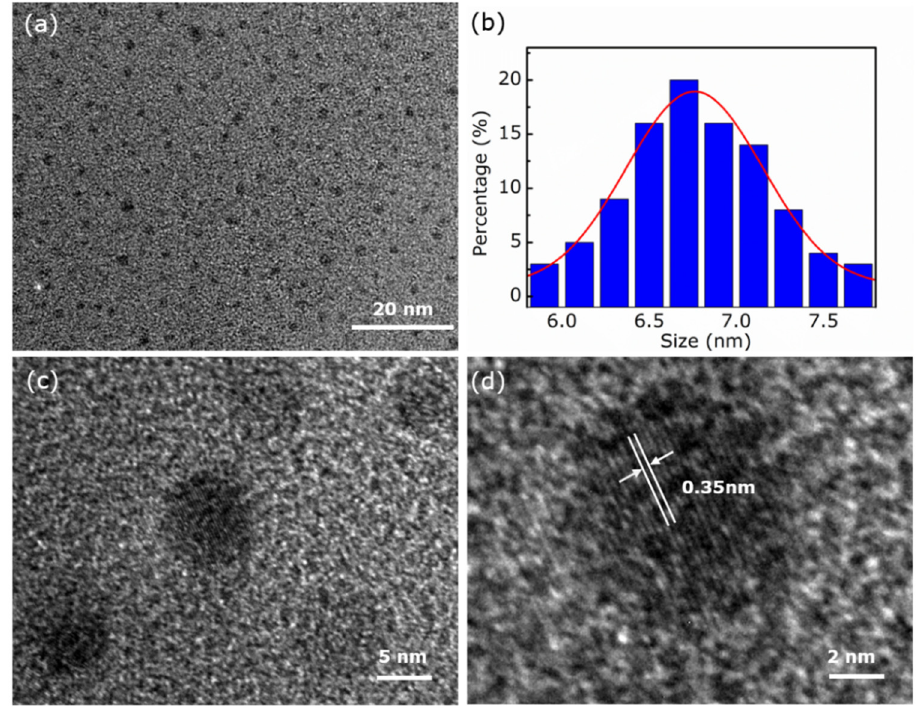
Figure 2. ( a ) TEM image, ( b ) particle size distribution analysis, ( c , d ) HRTEM images of OCNQDs.